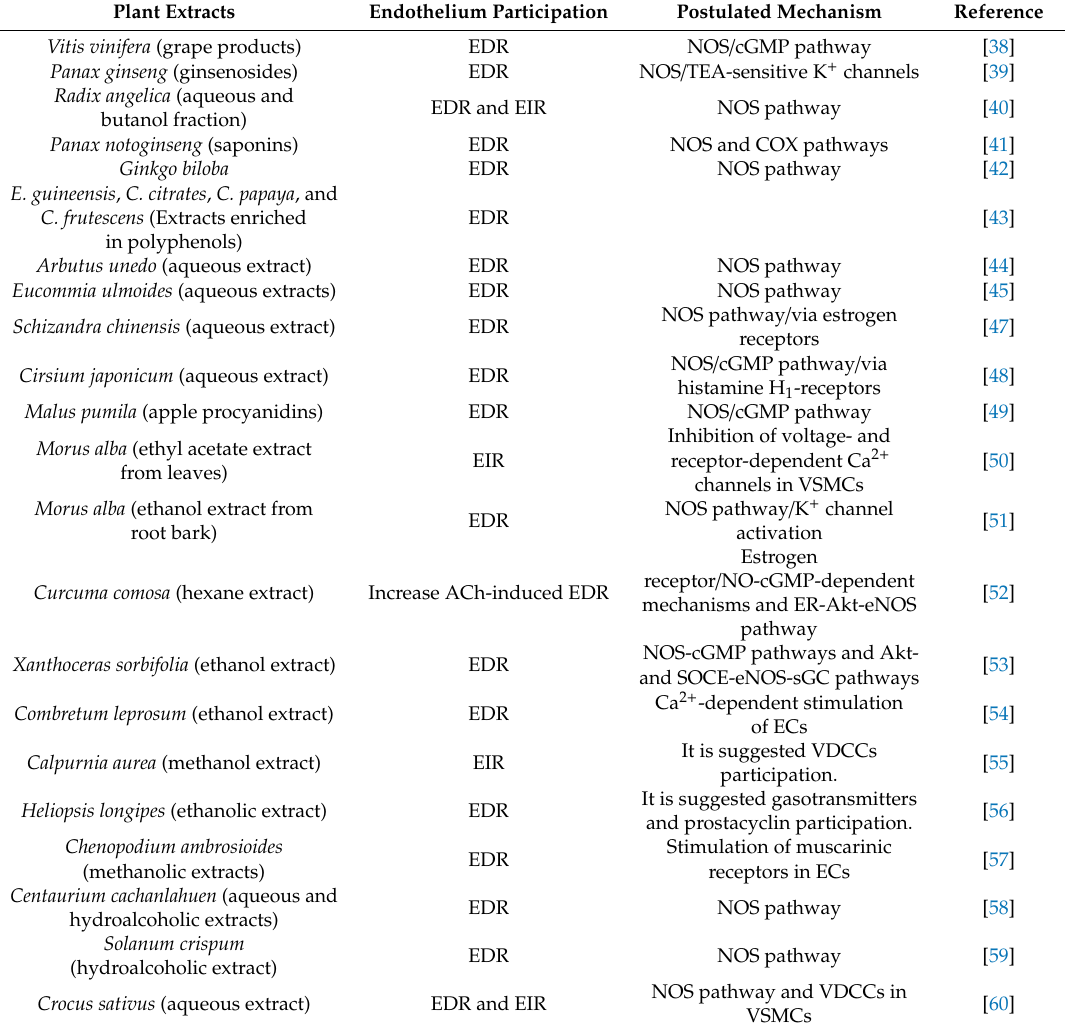
Table 1. Summary of vasodilator e ff ects induced by plant extracts in isolated rat aorta